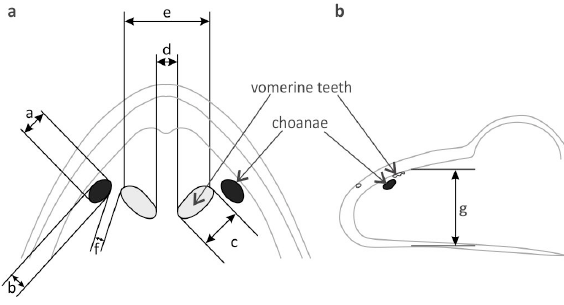
Figure 1. Diagrammatic illustration of the roof of buccal cavity indicating the measured distances. (a) ventral view of the roof and (b) sagittal